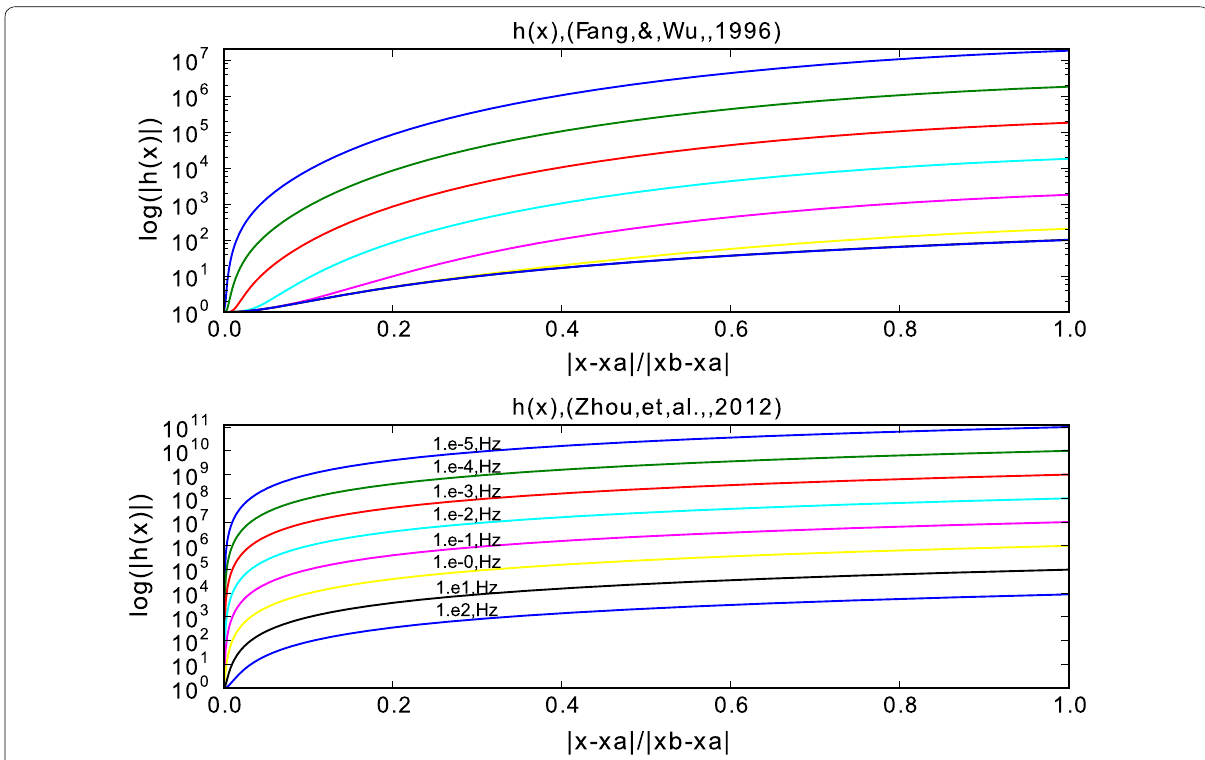
Fig. 3 Top panel shows the magnitude of stretching factor from Fang and Wu (1996), for fixed parameters a 0 = 100 and b 0 = 10 − 10 . Bottom panel shows that from Zhou et al. (2012), with a min = 0 , a max = 100 , b min = 10 − 2 , b max = 10